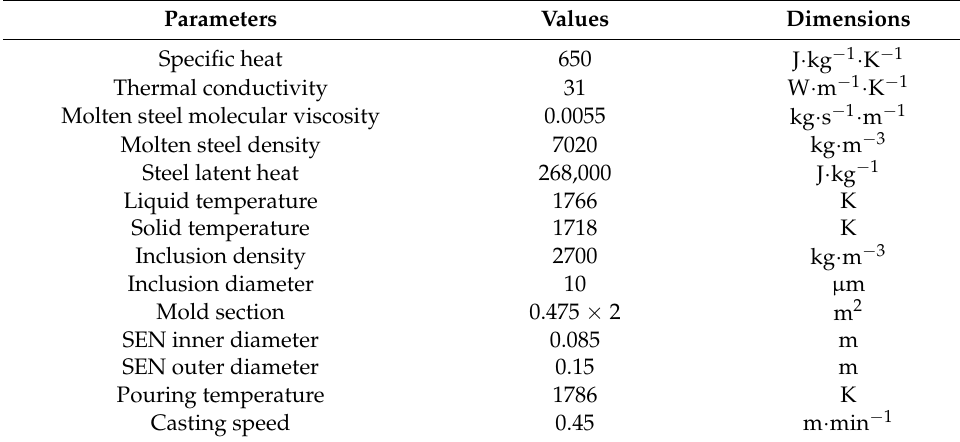
Table 1. The physical parameters and model